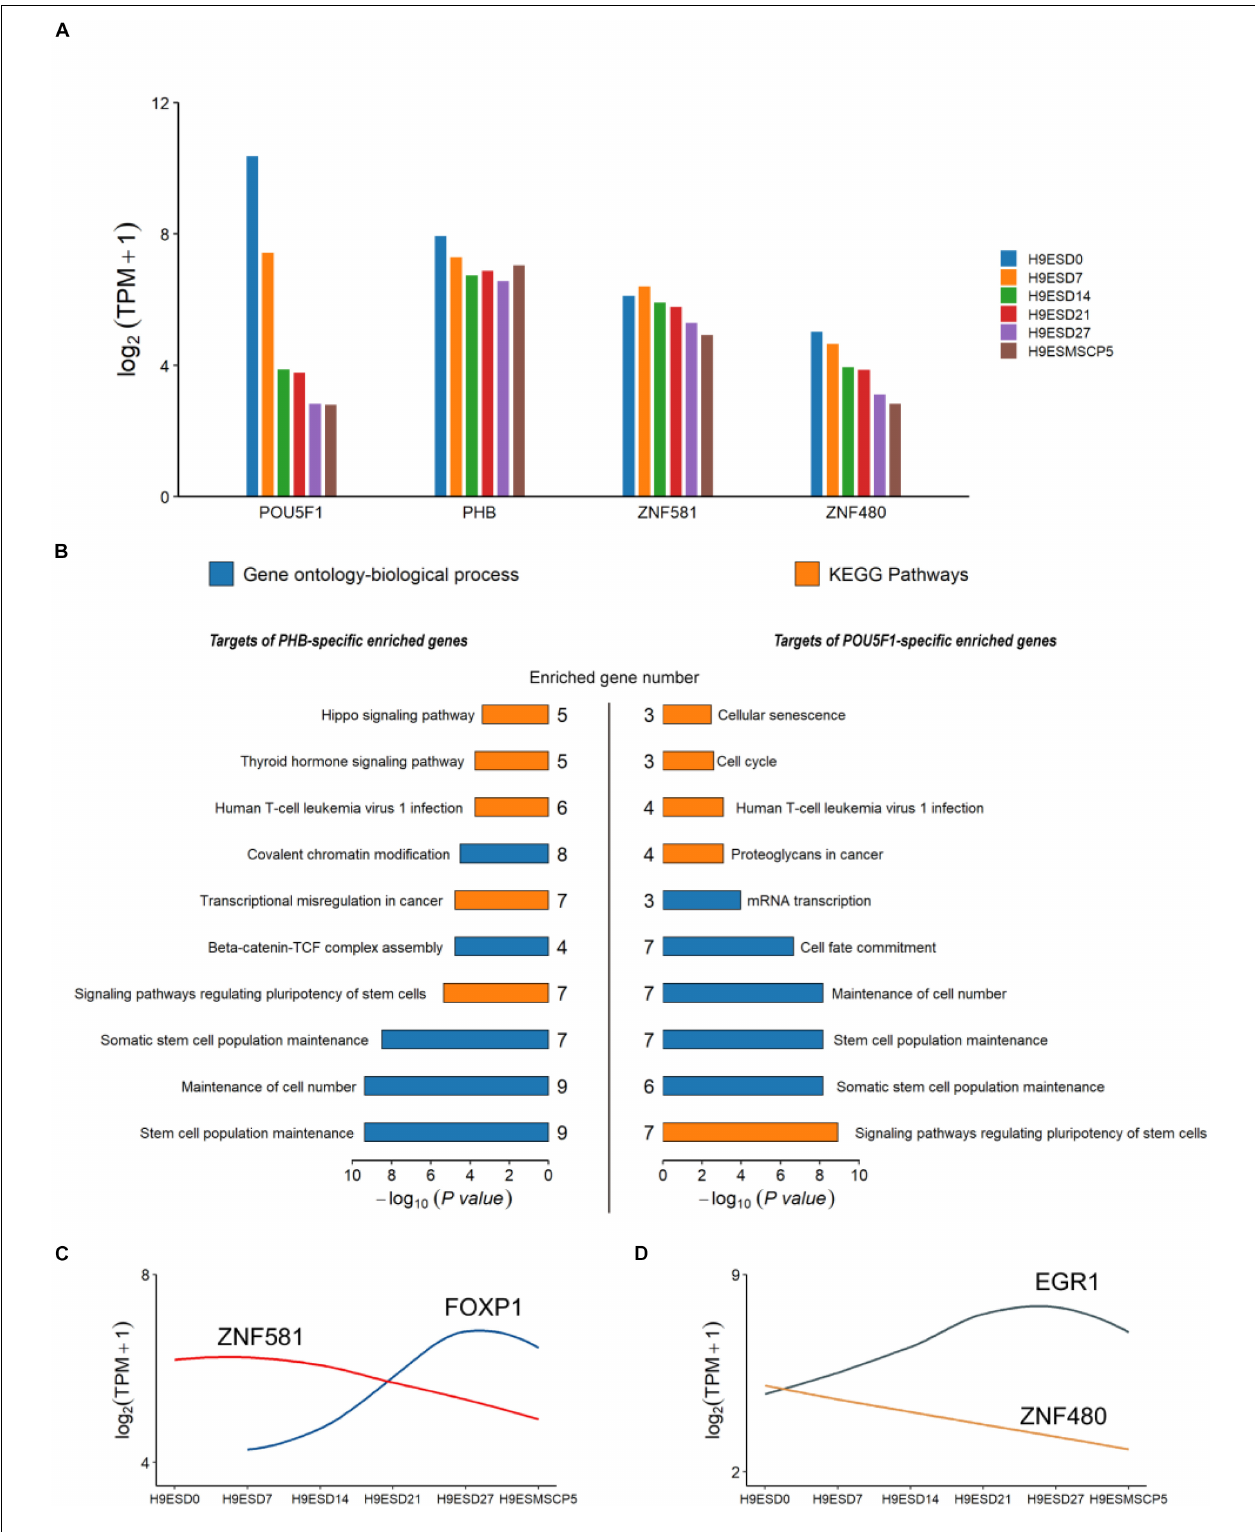
FIGURE 5 | The expression and annotation of four common TFs which appeared in all three types of embryo. (A) Expression of POU5F1, PHB, ZBF581, and ZNF480 from the human embryonic stem cell (hESC) to the induced mesenchymal stem cell (MSC). (B) Gene Ontology (GO) and KEGG pathways enriched for target genes of PHB and POU5F1. The p -values were calculated using the Benjamini-corrected test. (C,D) The dynamic expression for ZNF581 and ZNF480 and their target genes.